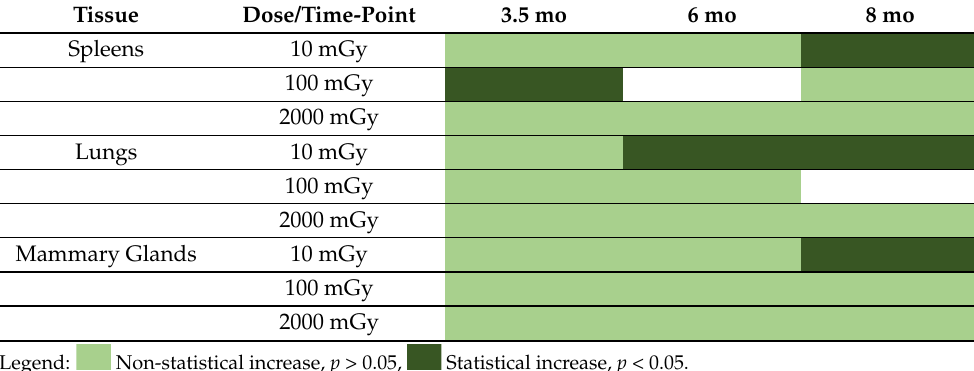
Table 1. Summary of LDR-induced NK cell proportion in different tissues. Tissue